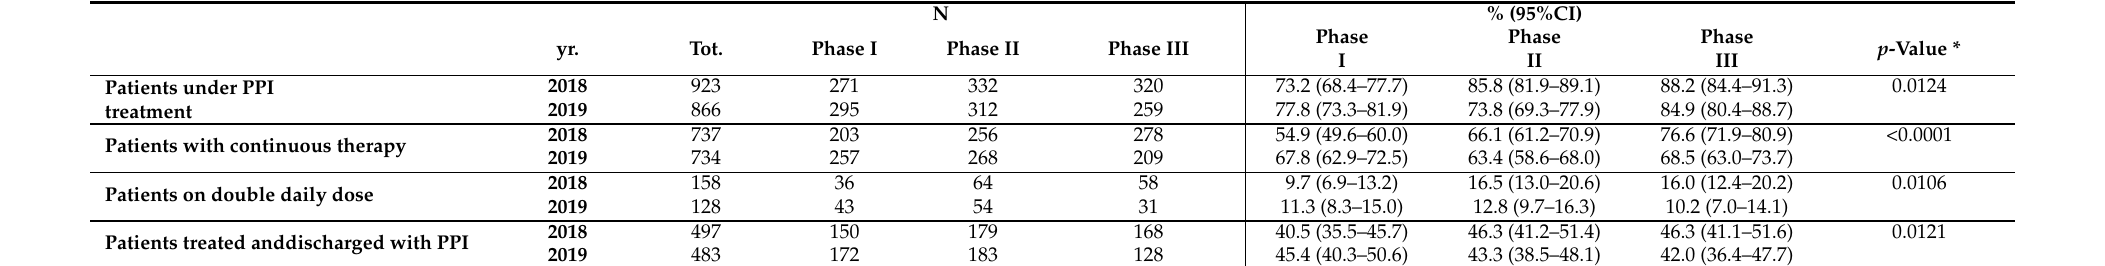
Table 3. Percentages (95% CI) of patients with respect to the total number of inpatients for each trimester/year.